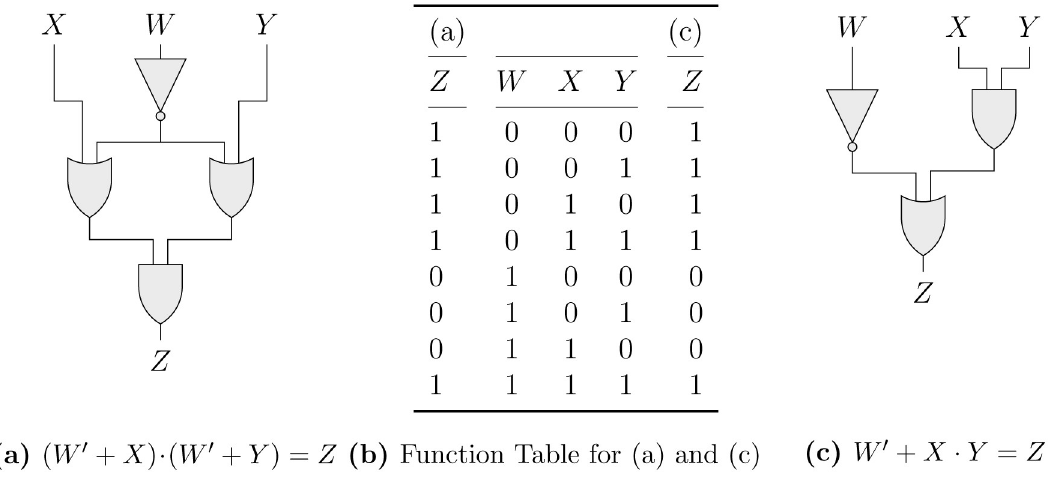
Fig 1. Two equivalent switching functions and their switching circuits. (a): ( W 0 + X ) � ( W 0 + Y ) = Z . (b): Function Table for (a) and (c). (c): W 0 + X � Y = Z .